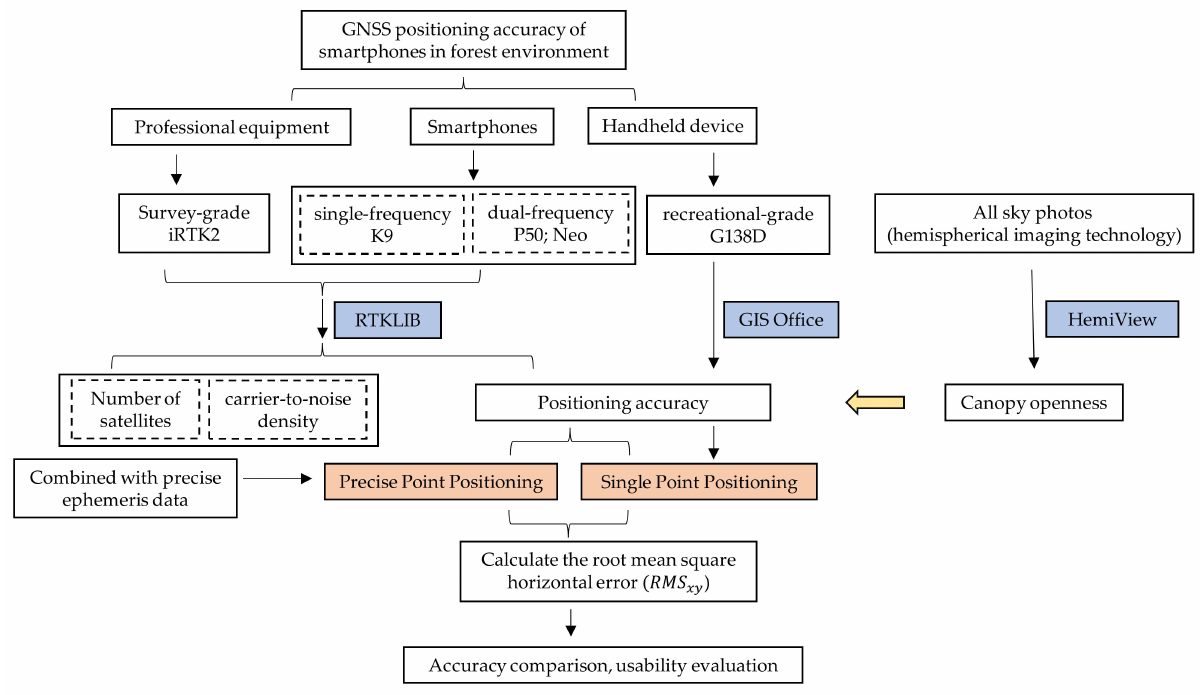
Figure 5. Methodology and data processing flow